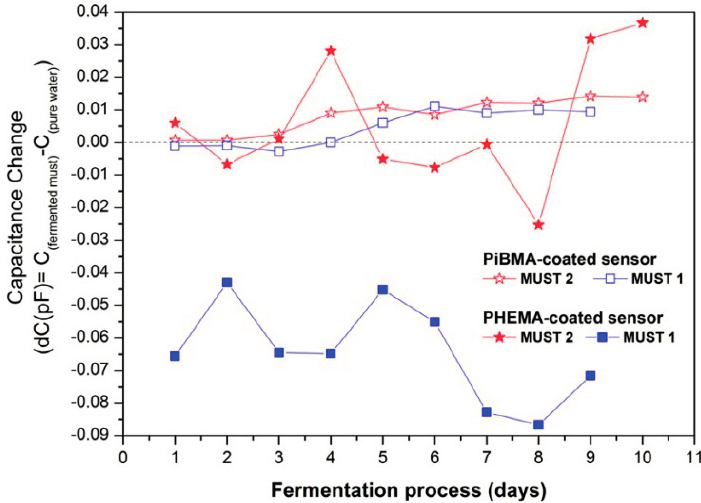
Figure 6. Differential equilibrium responses of the relative hydrophobic P(iBMA)-coated sensor and the relative hydrophilic PHEMA-coated sensor over fermentation